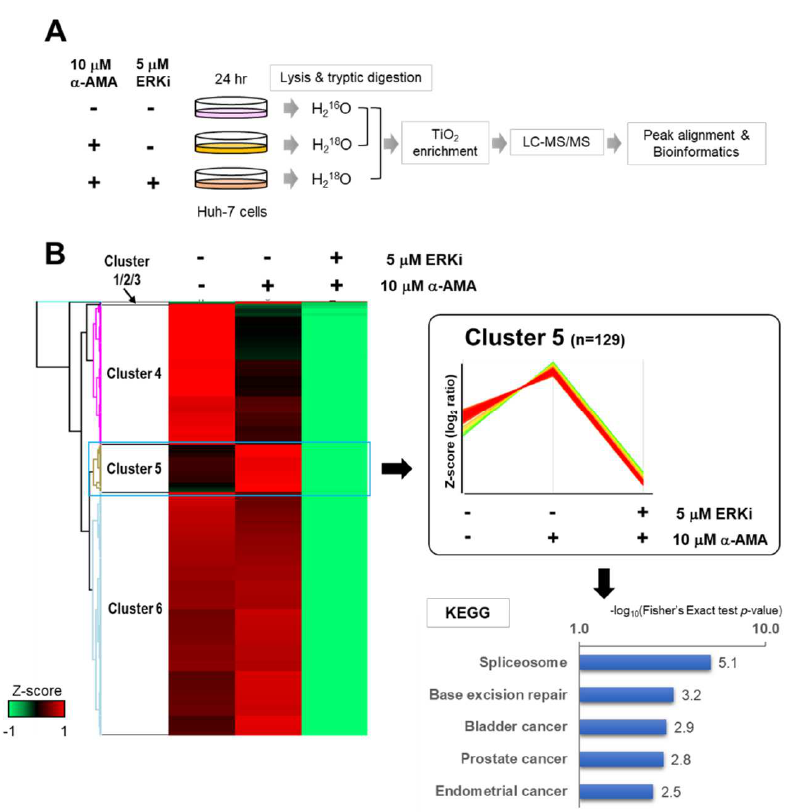
Figure 4. Global phosphoproteomic profiling of α-amanitin (α-AMA) target factors induced by RAS/RAF/ERK signal-pathway activation . ( A ) Flow chart of the comparative phosphoproteome. Huh-7 cells were treated with α-AMA (10 μM) and/or ERK1/2 inhibitor (FR180204, 5 μM) for 24 h. ( B ) Cluster 5 selected by unsupervised hierarchical clusters of phosphorylation after α-AMA treatment of Huh-7 cells with ERK 1/2 inhibitor. Heatmap between each time point of α-AMA treatment after Z-score normalization. DAVID-generated Kyoto Encyclopedia of Genes and Genomes (KEGG) pathway analysis of Cluster 5.